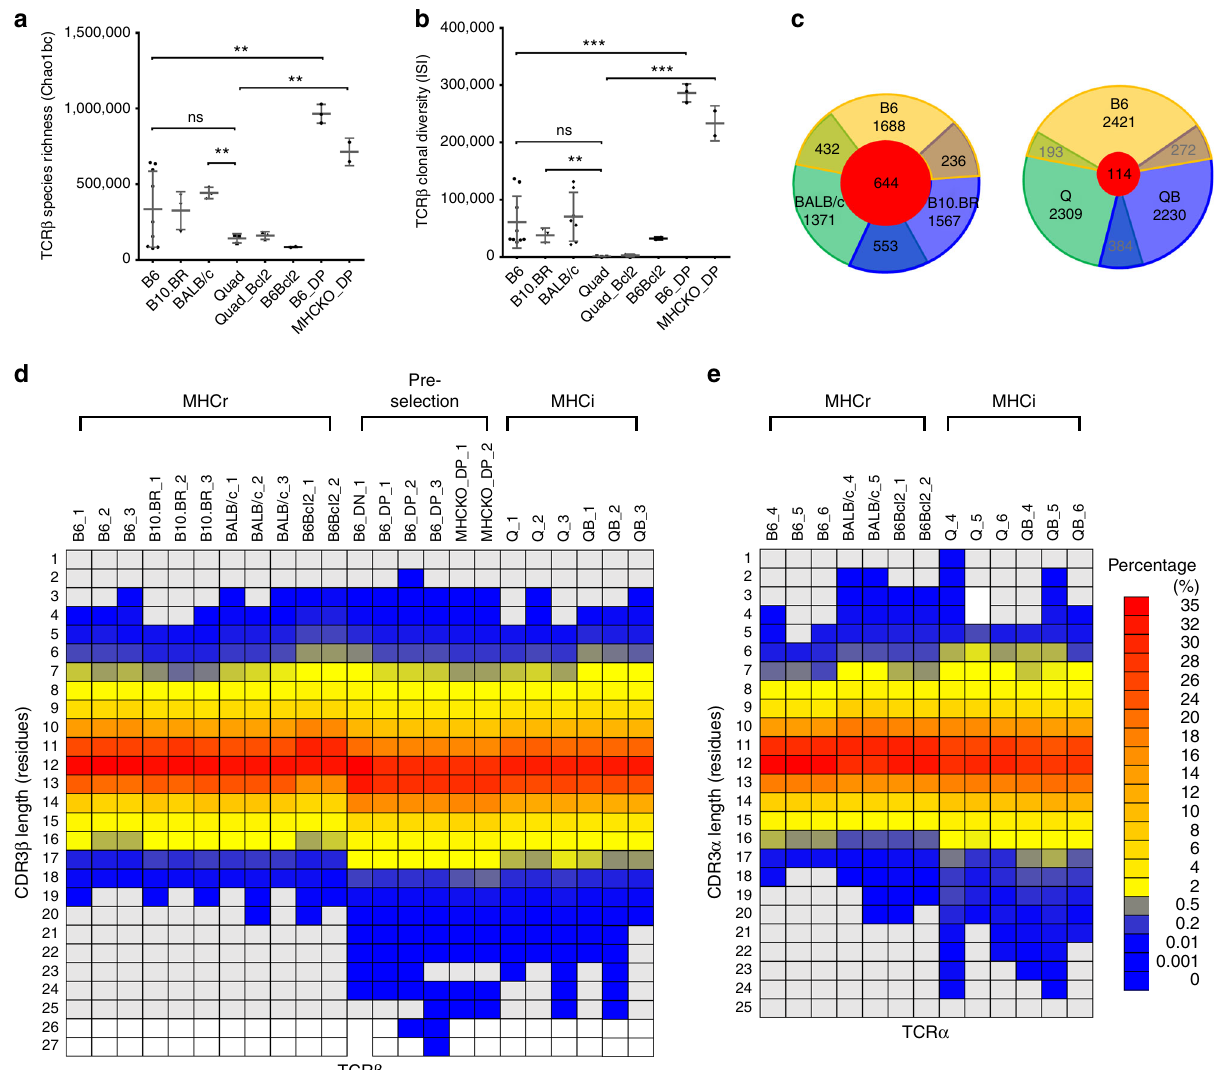
Fig. 3 Sequence diversity and CDR3 length distributions. a TCR β species richness of various TCR β repertoires based on Chaobc1 analysis. b The inverse simpson index (ISI) was calculated to estimate the clonal diversity of various TCR β repertoires. c TCR β sequence overlapping among the top 3000 common sequences to B6 DP1 from B6, B10.BR, BALB/c, Quad ko (Q), or Quad ko Bcl-2 tg (QB). d , e Heatmap showing CDR3 length distributions of TCR β ( d ) and TCR α ( e ) for various MHCr, MHCi and pre-selection repertoires. The mice are identi fi ed with a number associated with their strain name (Table S1-S2). For strains with more than three sequencing attempts, only three repertoires are shown